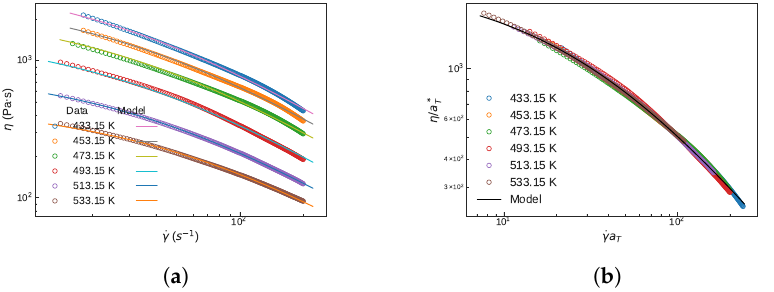
Figure 13. ( a ) Viscosity vs. shear rate at 6 different temperatures; and ( b ) the obtained master